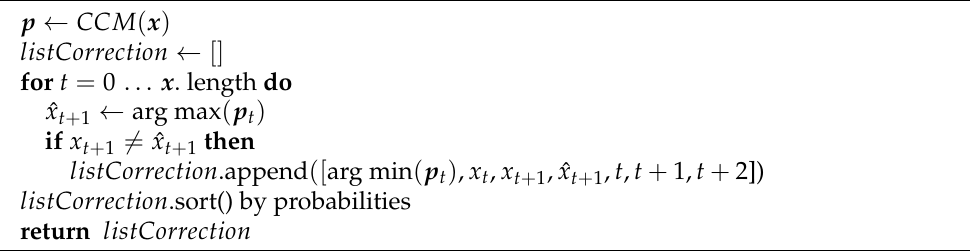
Algorithm 1 listCorrection = Localization of logic errors ( x